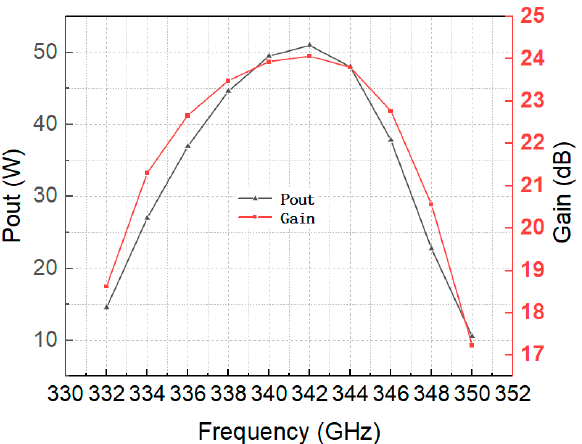
Figure 11. The output power and gain of multi-beam overmoded SWG TWT versus the operating frequency.